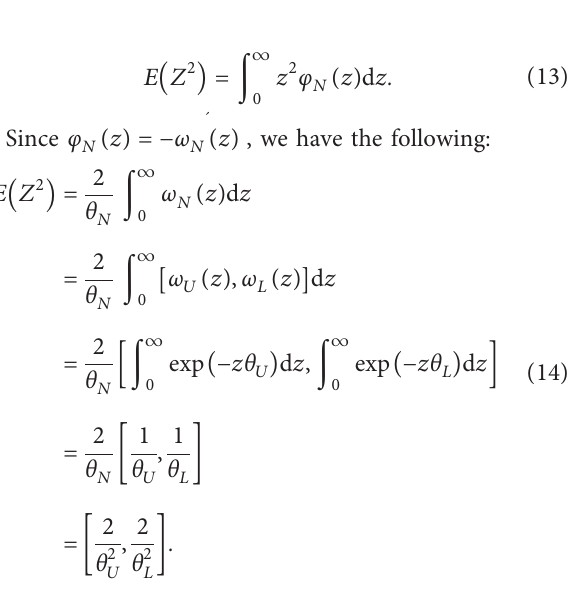
Figure 2: The function ω